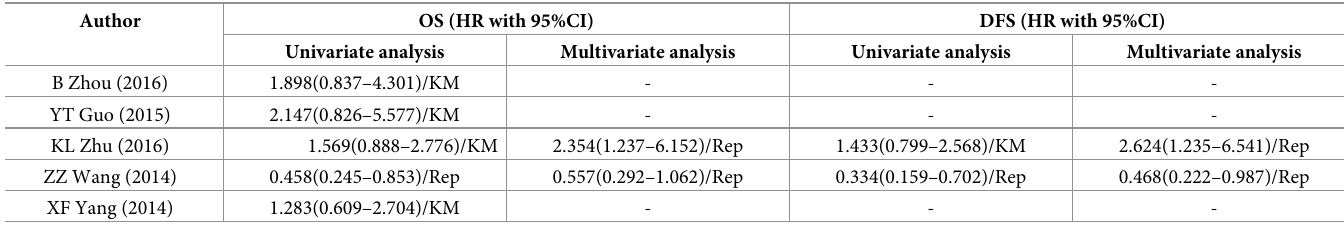
Table 3. Summary of HR with 95%CI for OS and DFS in each